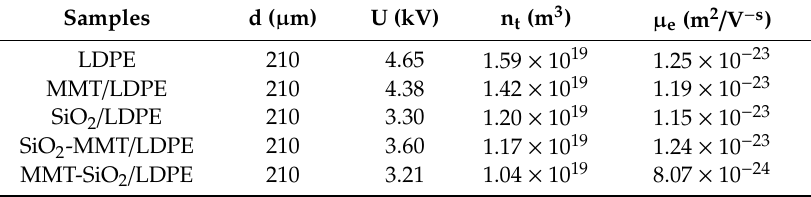
Table 2. Calculation results of trap density and carrier mobility of each